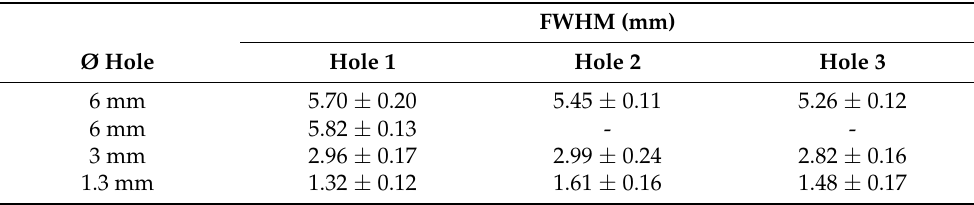
Table 2. Calculated FWHM of the 1D profiles for the different regions of interest depicted in Figure 16.